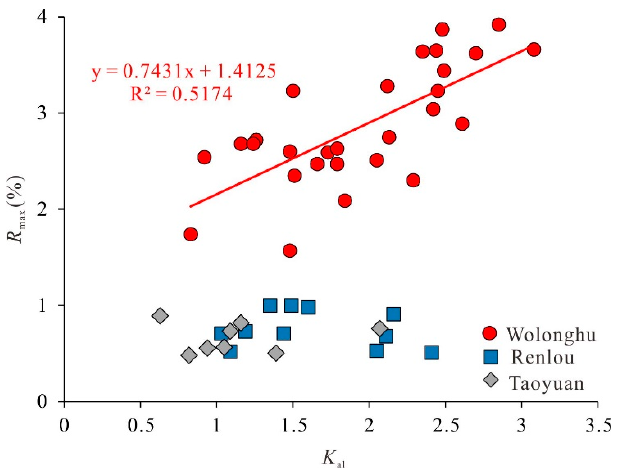
Figure 13. Correlation between K al and R max of selected coal samples in the Huaibei Coalfield.